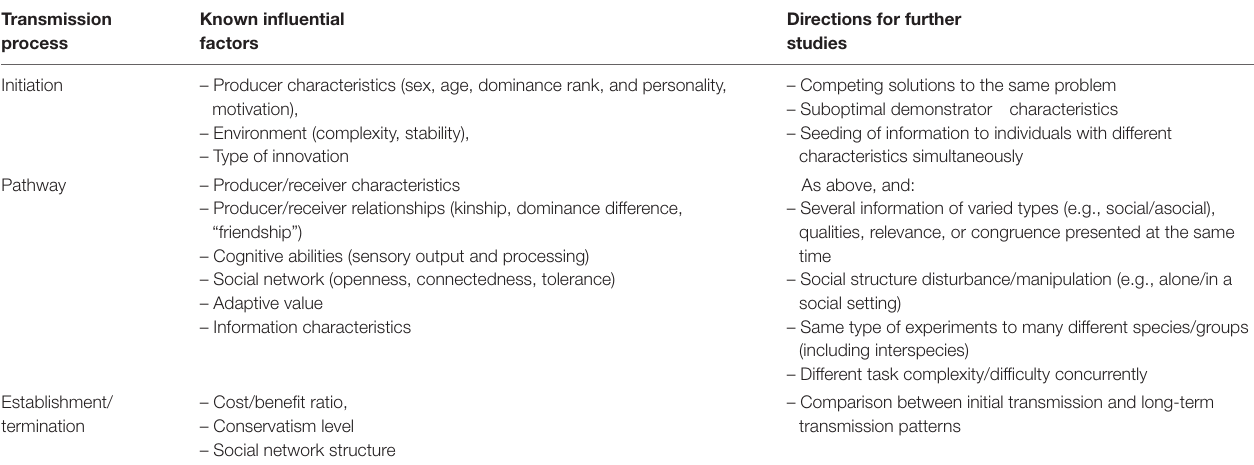
TABLE 1 | Summary of points examined in this